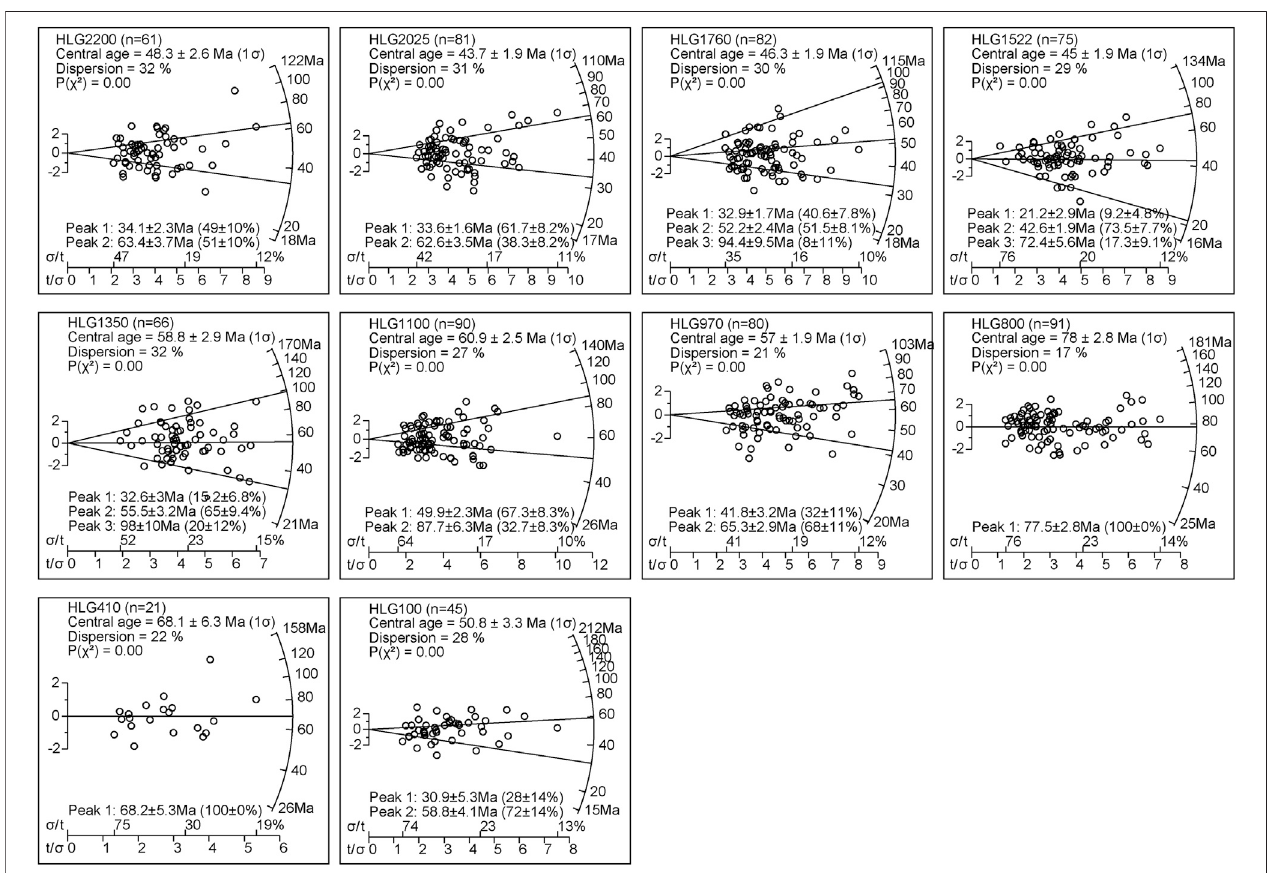
FIGURE 3 | Radial plots of the analysed AFT samples constructed using the RadialPlotter programme (Vermeesch, 2012).